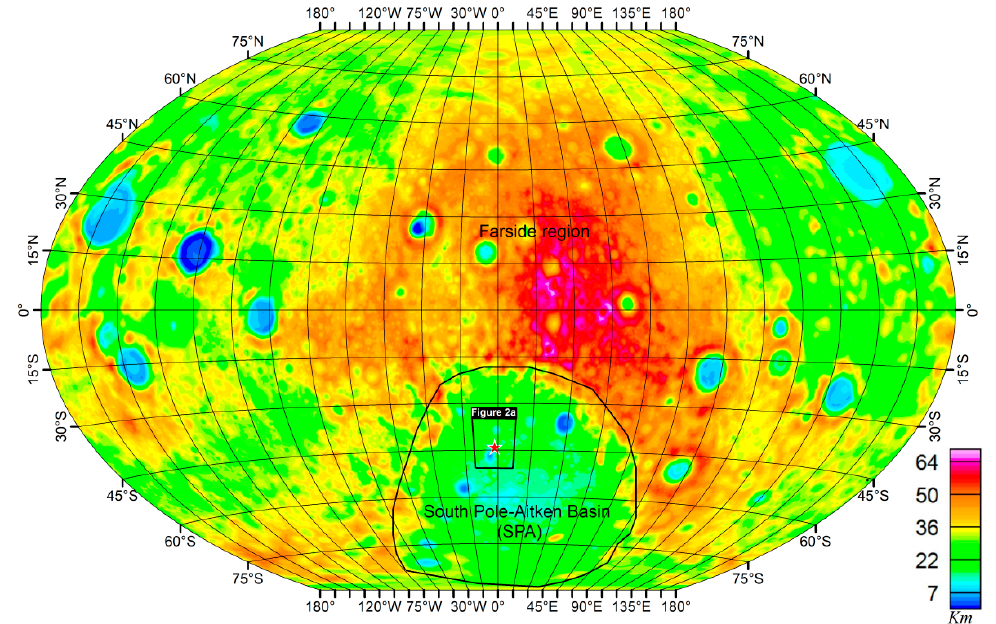
Figure 1. The crustal thickness map of the Moon, centered on the farside (Winkel tripel projection [7]). Also shown are the locations of the South Pole-Aitken Basin and the Von Kármán Crater. The black polygon shows the extent of the study area, which includes the Von Kármán Crater and surrounding craters. The red pentagram indicates the location of the Chang’E-4 landing site (177.59°E, 45.46°S; [11,12]).